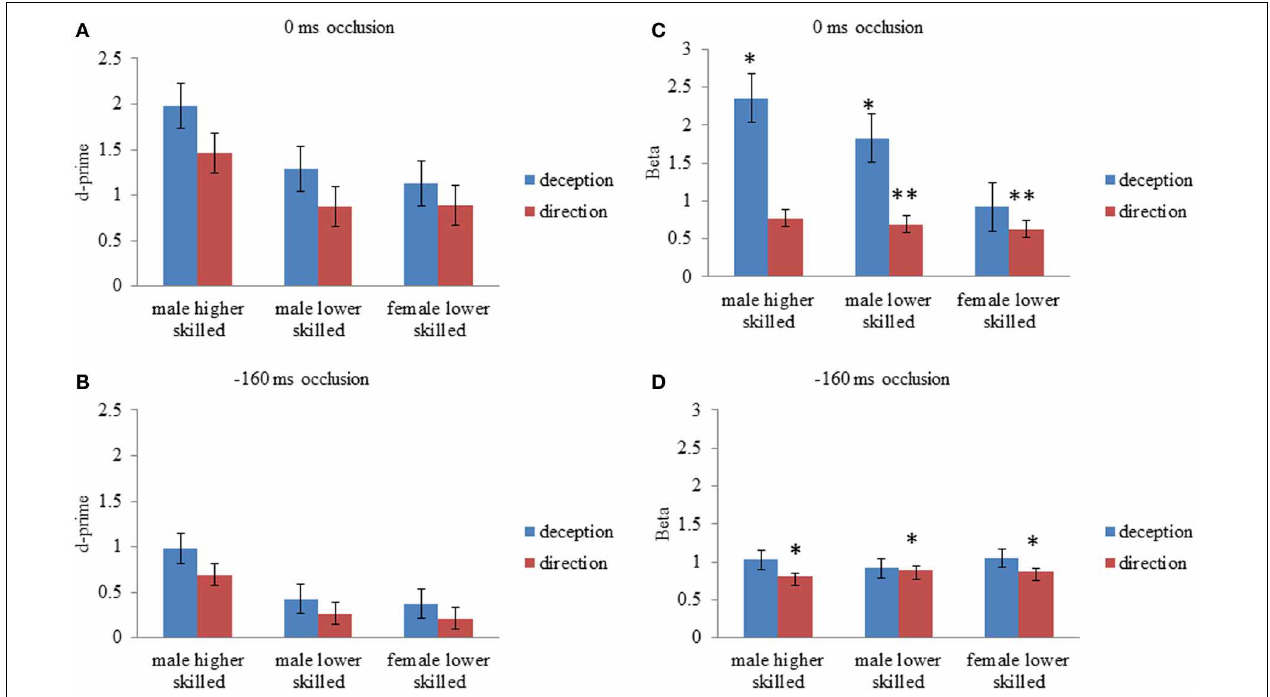
FIGURE 2 | Mean values for d-prime (d (cid:2) ); perceptual sensitivity, and Beta ( β ); likelihood ratio or response bias, for all experimental conditions. (A) d (cid:3) , 0ms occlusion; (B) d (cid:3) , − 160ms occlusion; (C) β , 0ms occlusion (D) β , − 160ms occlusion. Error